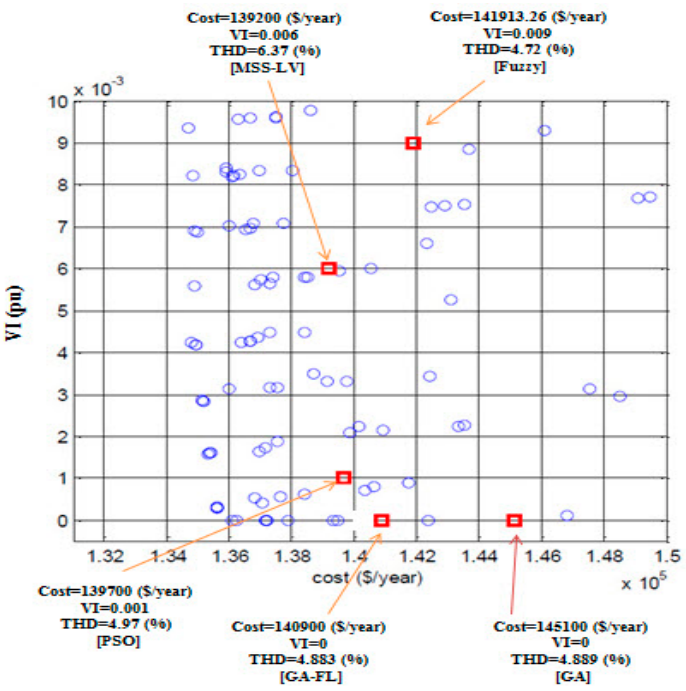
Figure 6. Magnification of the results of the proposed method with the two objectives of cost and VI, along with comparison with other methods.